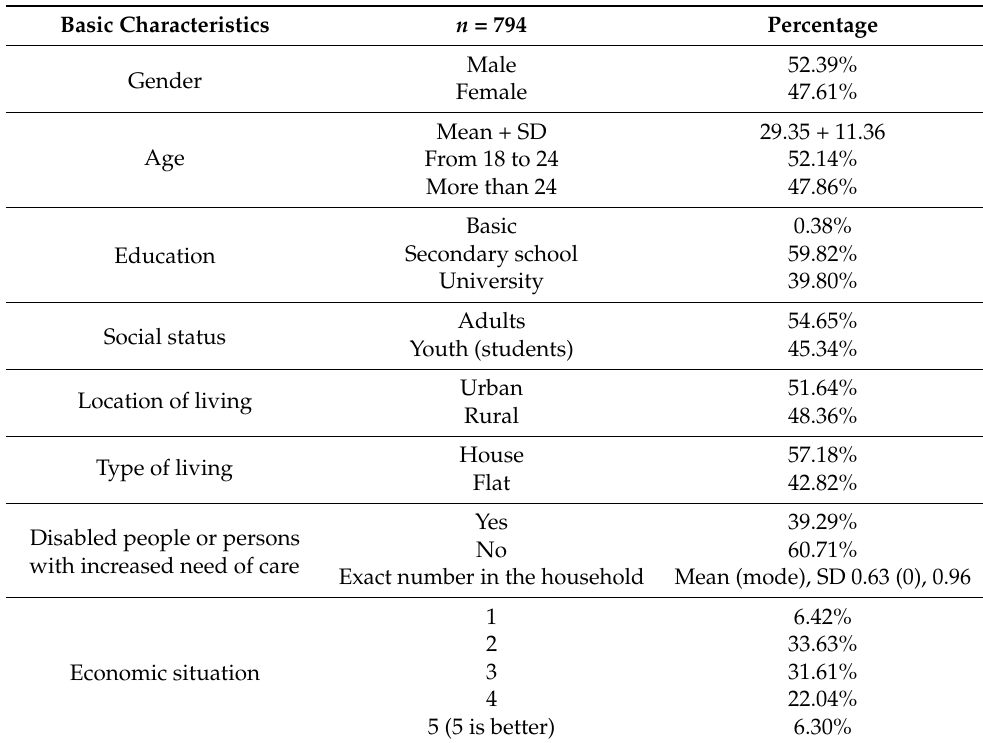
Table 2. Basic attributes and characteristics of the